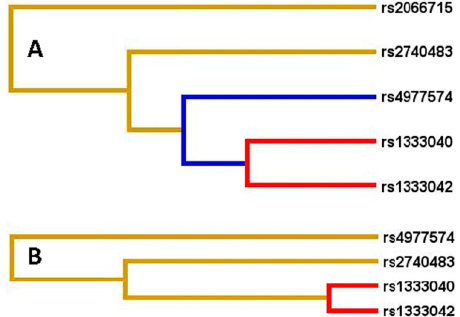
Figure 3. Diagram for gene–gene interactions on the risk of CHD ( A ) and IS ( B ). Red color, strong interaction; blue color, moderate interaction; yellow color, weak interaction.